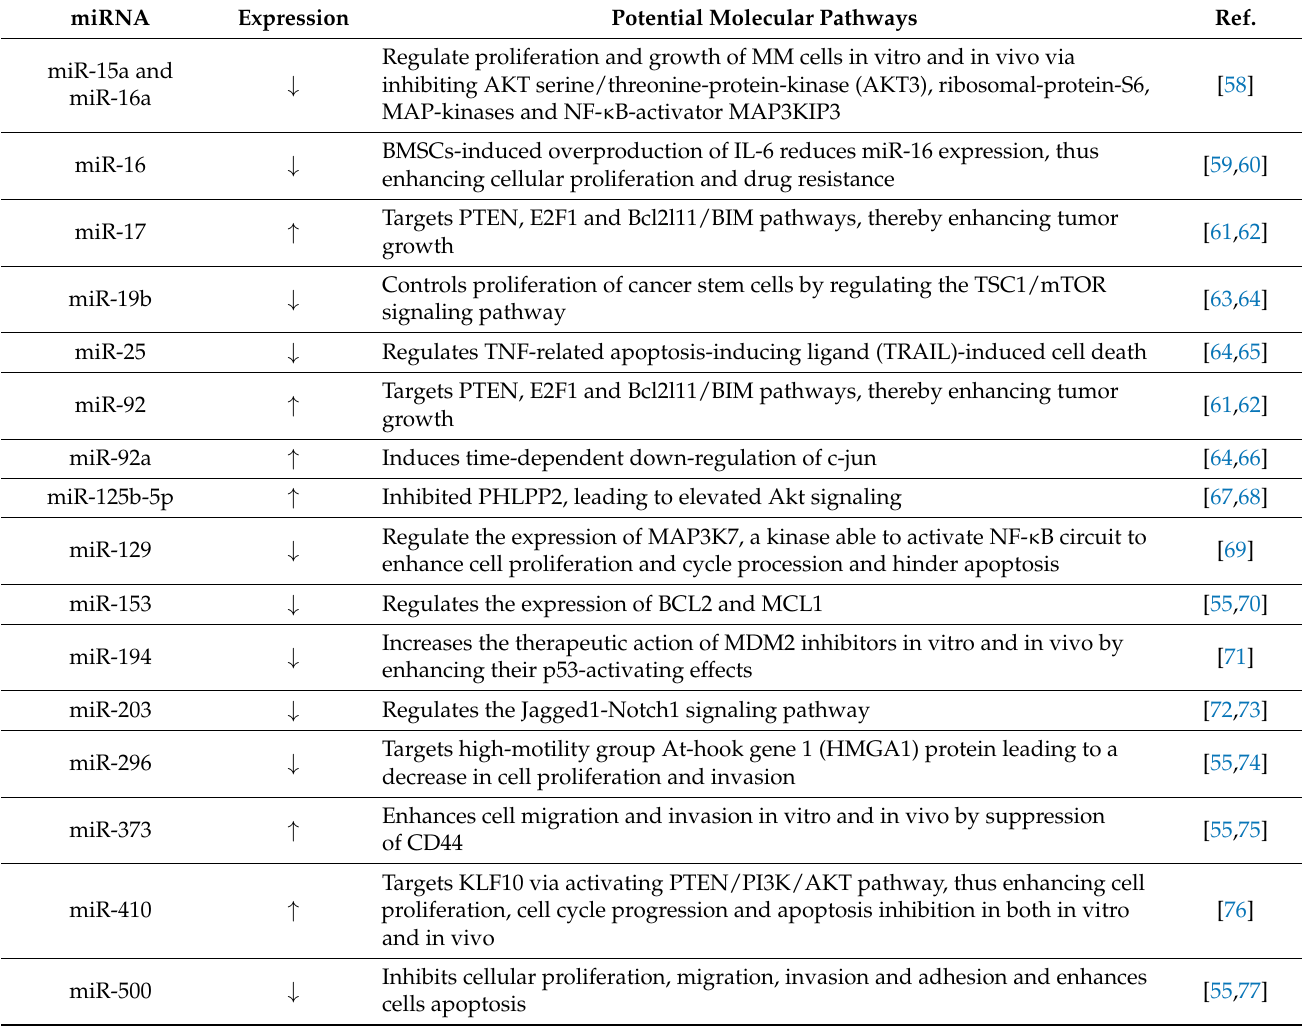
Table 1. MiRNAs acting as potential diagnostic and/or prognostic biomarkers in MM and their molecular targets. miRNA Expression Potential Molecular Pathways